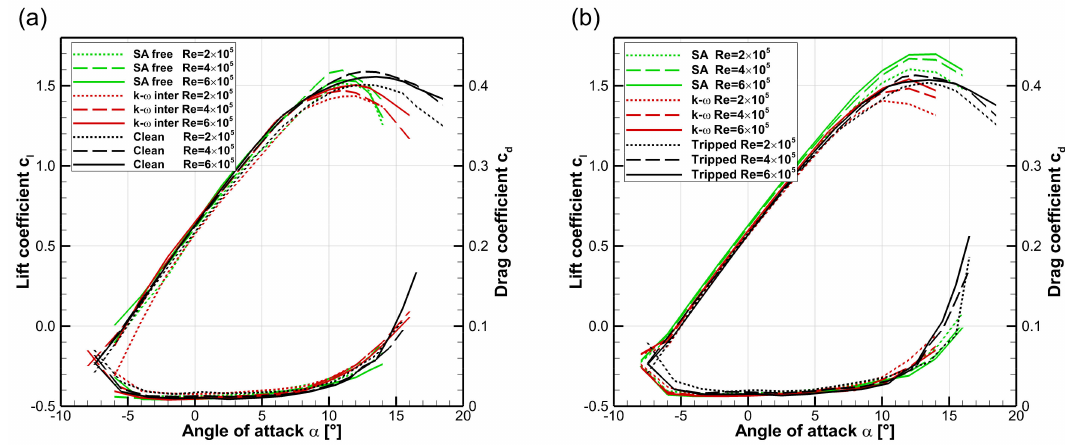
Figure 9. Comparison between numerical and experimental results of lift and drag for the clean ( a ) and the tripped ( b )